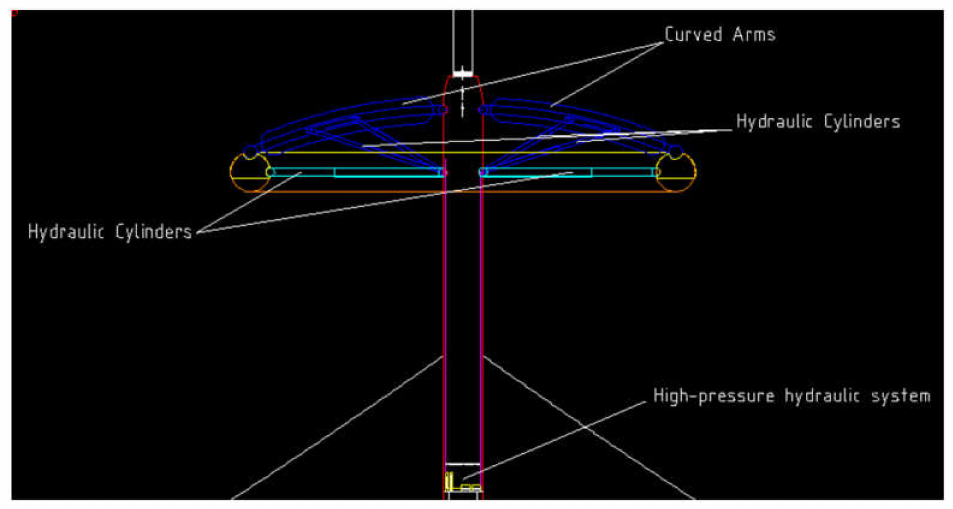
Figure 2. HWWES: WEC cross-section.